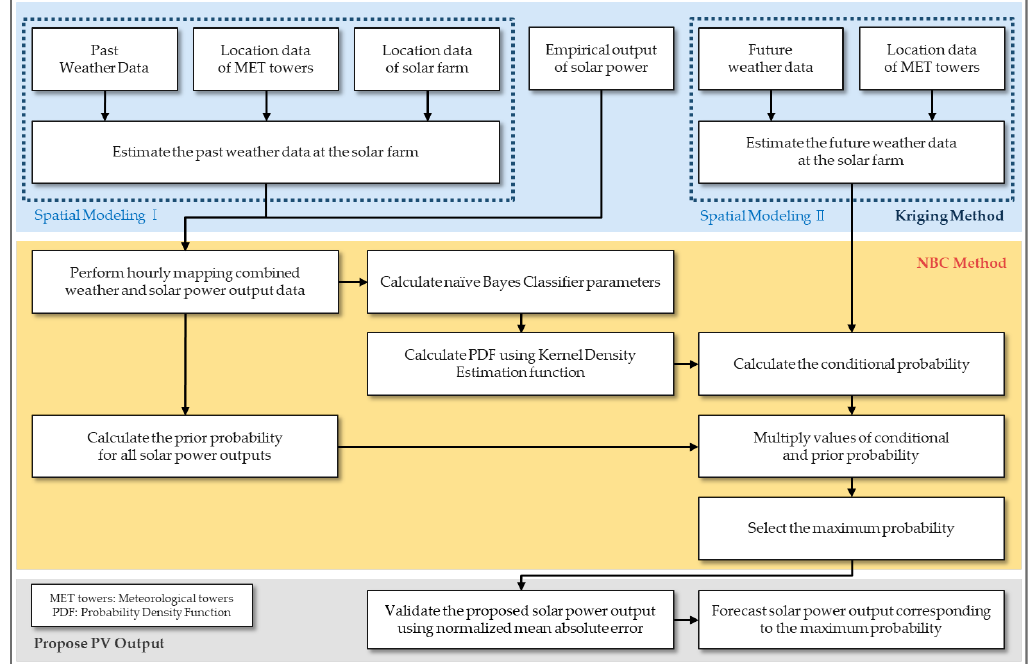
Figure 1. Algorithm for the hybrid spatio-temporal forecasting model.